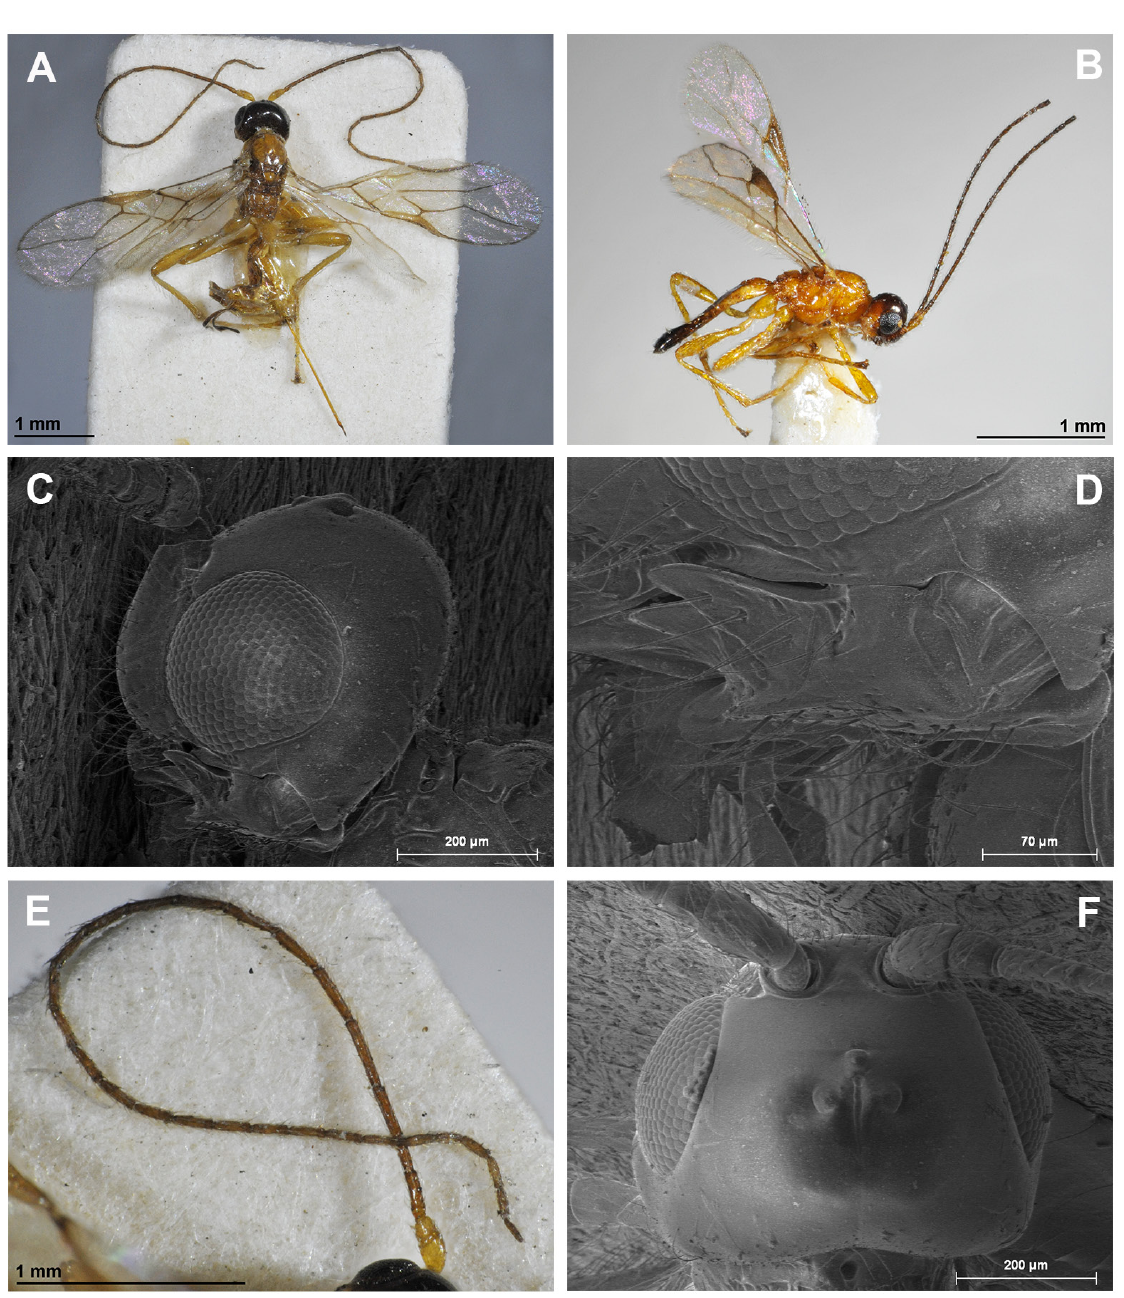
Fig. 33. Asobara kobacsi (Papp, 1966), A, C–F: ♀, holotype (HNHM); B: ♂ (BMNH 1927-54). A–B . Habitus, lateral view. C . Head, lateral view. D . Mandible. E . Antenna. F . Head, front